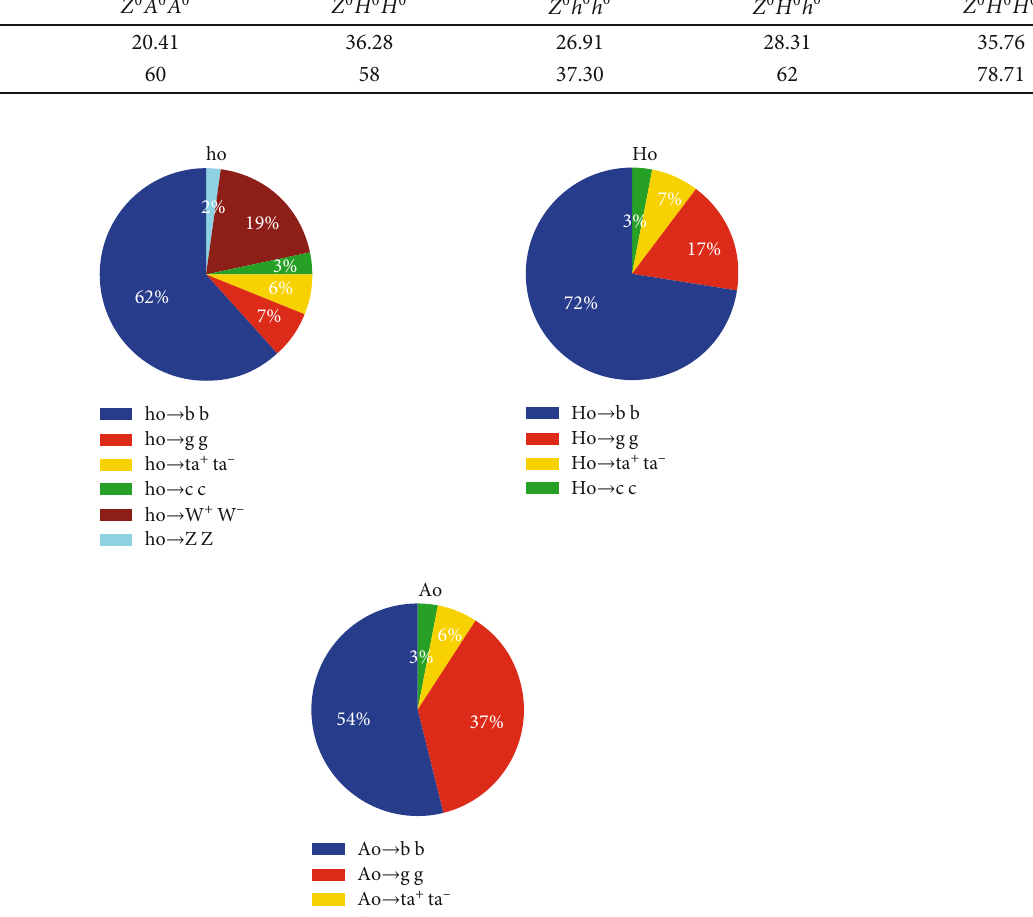
Table 6: The percentage of events for di ff erent decay channels is computed by evaluating the branching ratios of each decay mode. Detector pattern